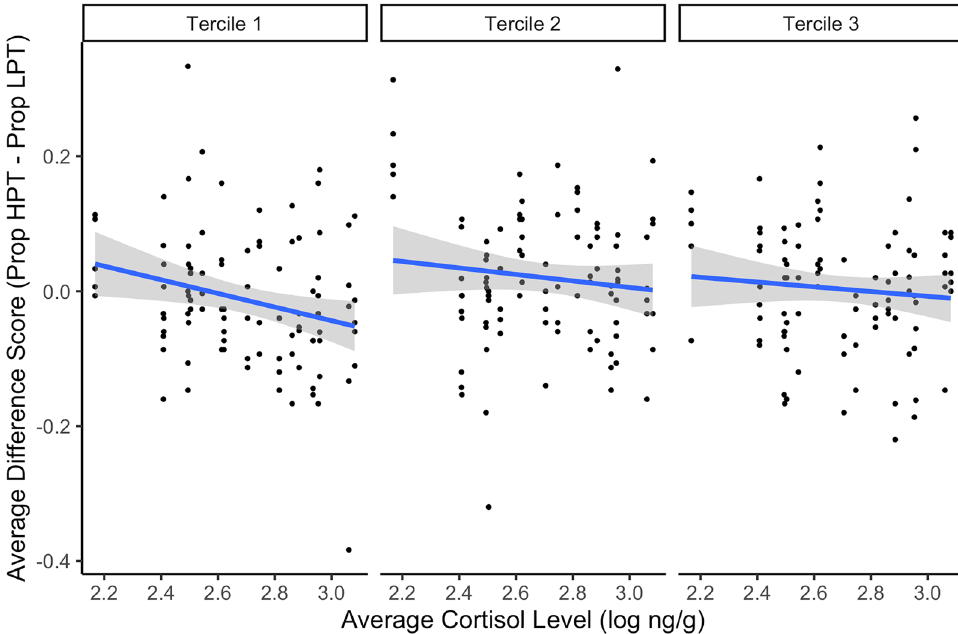
Figure 3. Cortisol’s relationship to performance, based on experience with the task. For visualization purposes, we split session numbers into three terciles (First tercile = sessions 1–5, Second tercile = sessions 6–10, and third tercile = sessions 11–15). Confidence bands represent a 95% confidence